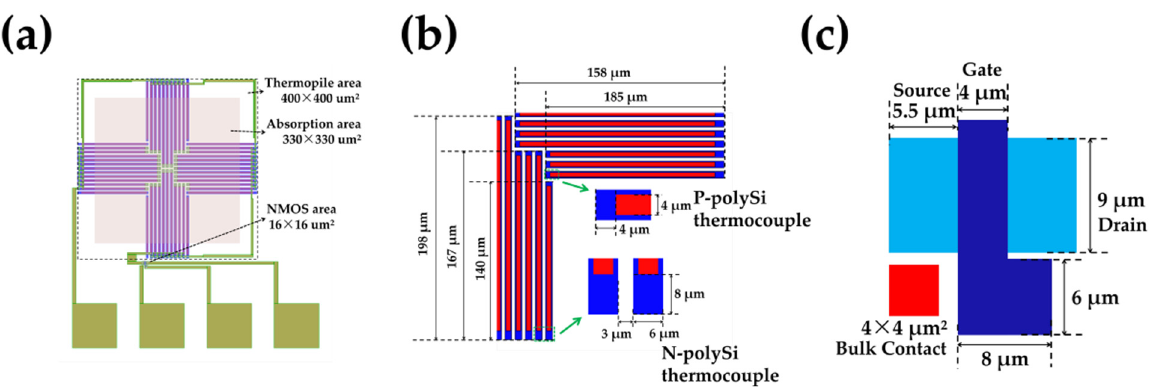
Figure 2. Schematics of ( a ) the TISA pixel, ( b ) the thermocouple and ( c ) the NMOS.